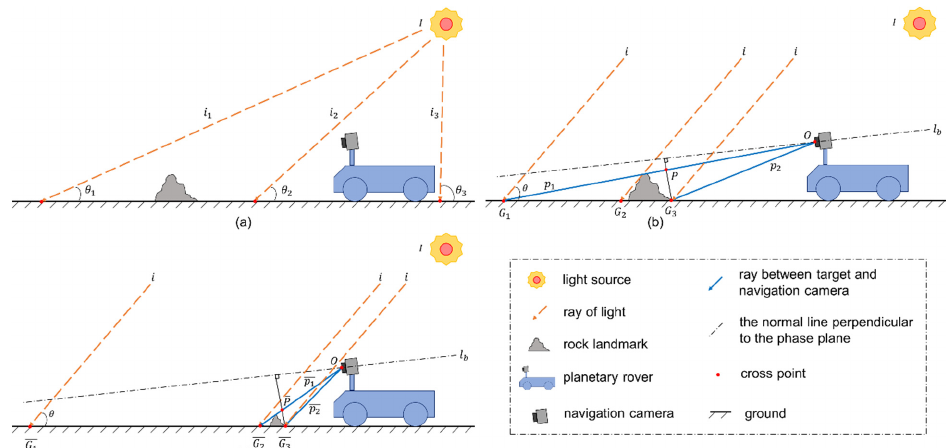
Figure 2. The sketches of the planetary rover navigations. ( a ) refers to the typical scenario of the planetary rover. ( b ) refers to the abstracted scenario through applying Equation (1) to ( a ). ( c ) refers to the abstracted scenario with a small and closer rock landmark compared to ( b ). G 1 , G 2 , G 3 , P , p 1 , and p 2 in the ( b ) scenario correspond to G 1 , G 2 , G 3 , P , p 1 , and p 2 in the ( c ) scenario,